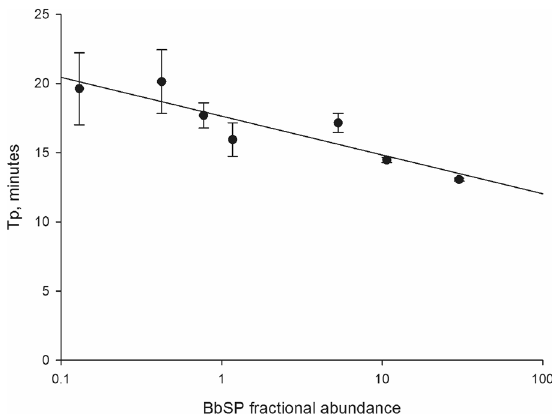
Figure 3. LAMP time to positive (T p ) in relation to levels of BBSP in naturally infected blueberry samples. Each data point represents the mean of 6 or 12 measurements. Spearman correlation between ddPCR-determined FA and LAMP T p was ρ = − 0.772, p < 0.0001, n =